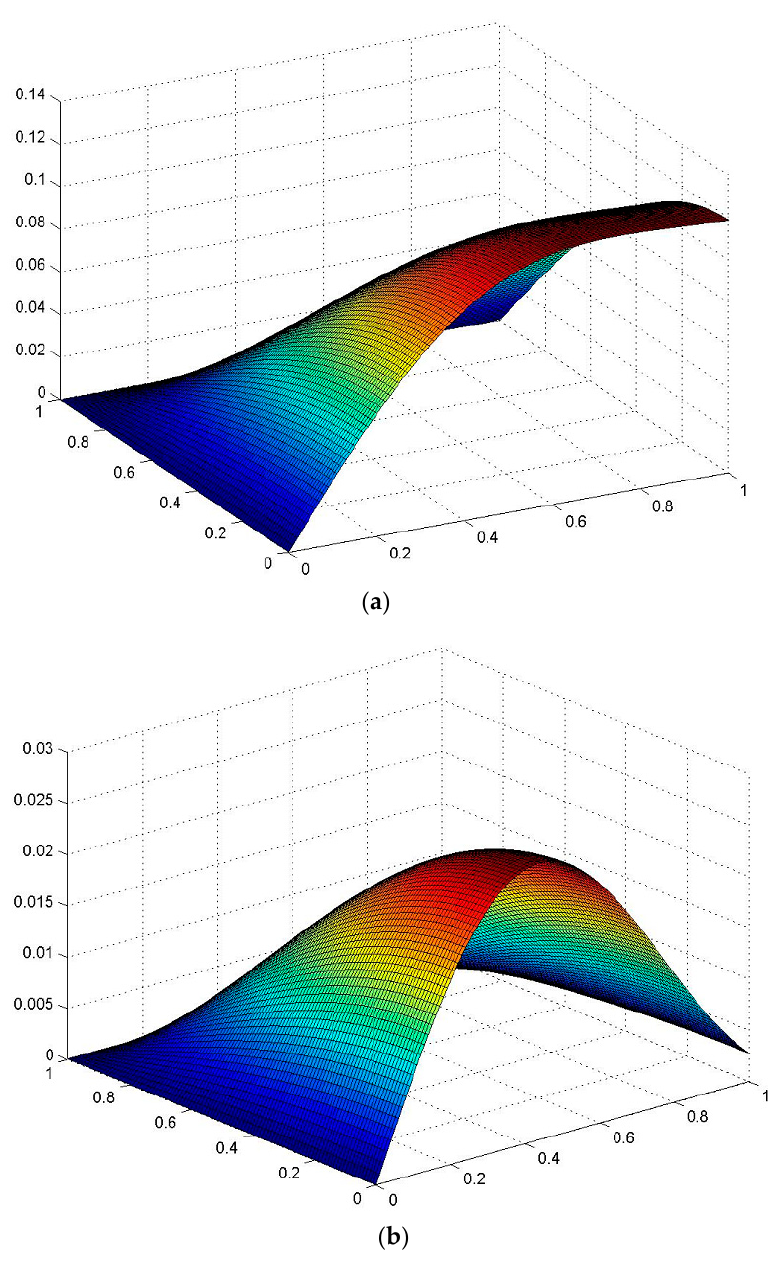
Figure 3. Vibration form of a rectangular plate of variable thickness at t = 78: ( a ) elastic at A ij = 0; ( b ) viscoelastic at A ij = 0.05